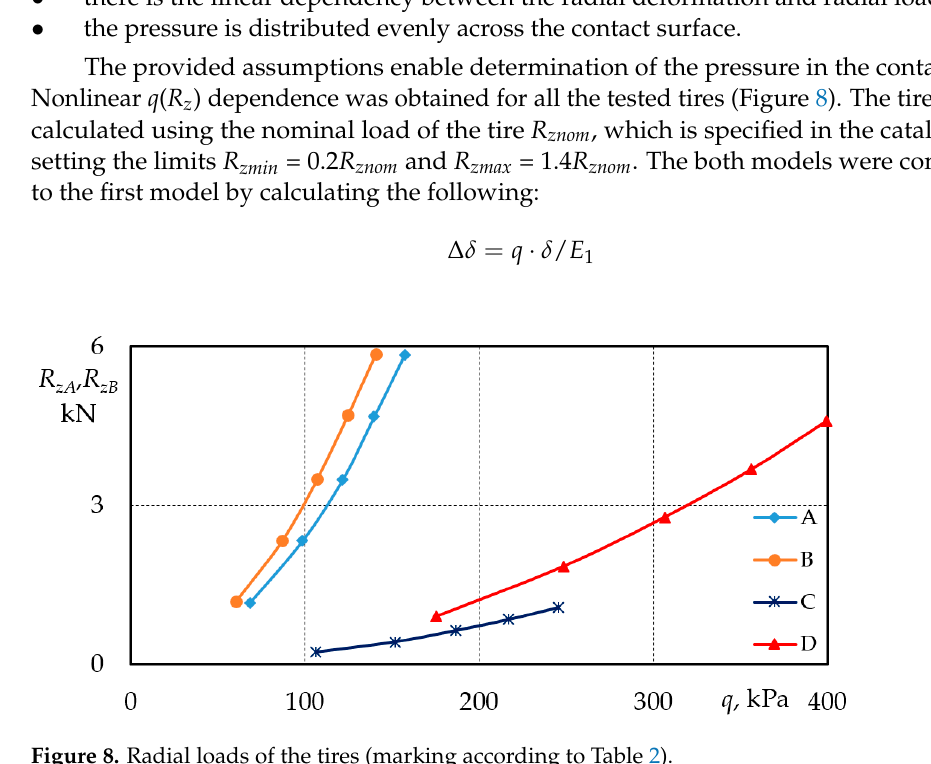
Figure 9. Dependence of relative stiffness of the tread part with a pattern on the relative radial load for different tires (compressed prism model; marking according to Table 2).